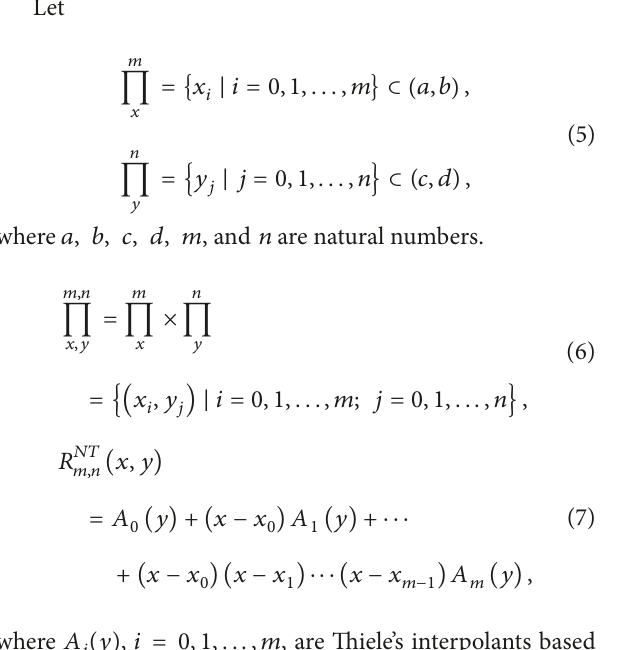
of the damaged point. When the intensities of all damaged points are got, the initial repaired image can be